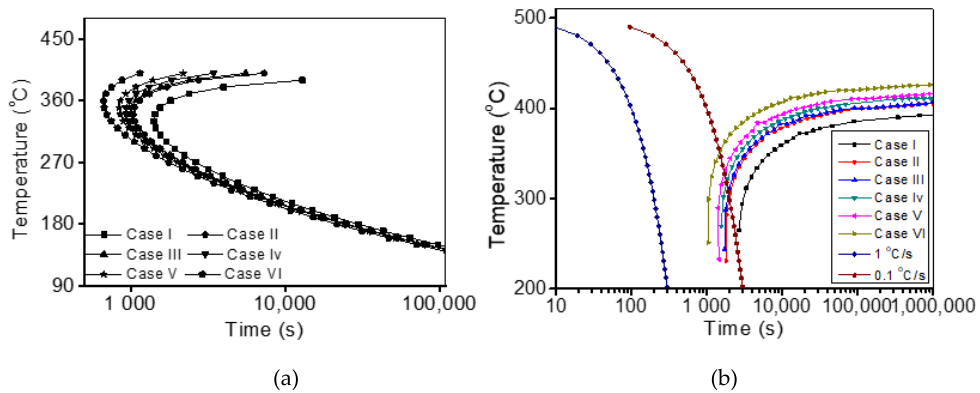
Figure 1. Calculated time-temperature-transformation (TTT) and continuous-cooling-transformation (CCT) curves of η ( MgZn 2 ) phase for 7085 aluminum alloy with different contents of main alloying elements: ( a ) TTT curves ( b ) CCT curves. Table 2. TTT curve parameters of η (MgZn 2 ) phase calculated using JMatPro. Main Alloying Elements Contents (wt.%)